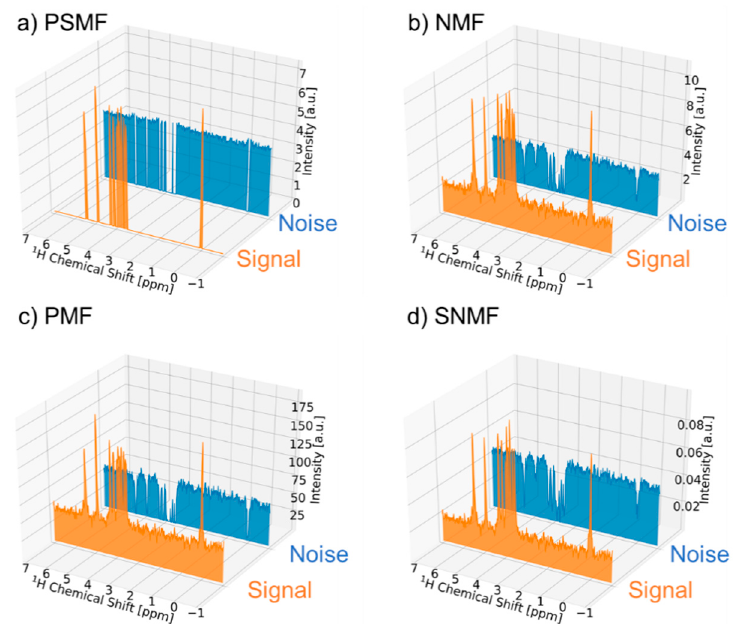
Figure 2. Comparison of four matrix factorization (MF) methods in signal deconvolution. Shown are spectral patterns of signal deconvolution for sucrose 1 H-NMR data using ( a ) PSMF, ( b ) NMF, ( c ) PMF, and ( d ) SNMF. The signal components are shown in orange and the noise components are shown in blue.